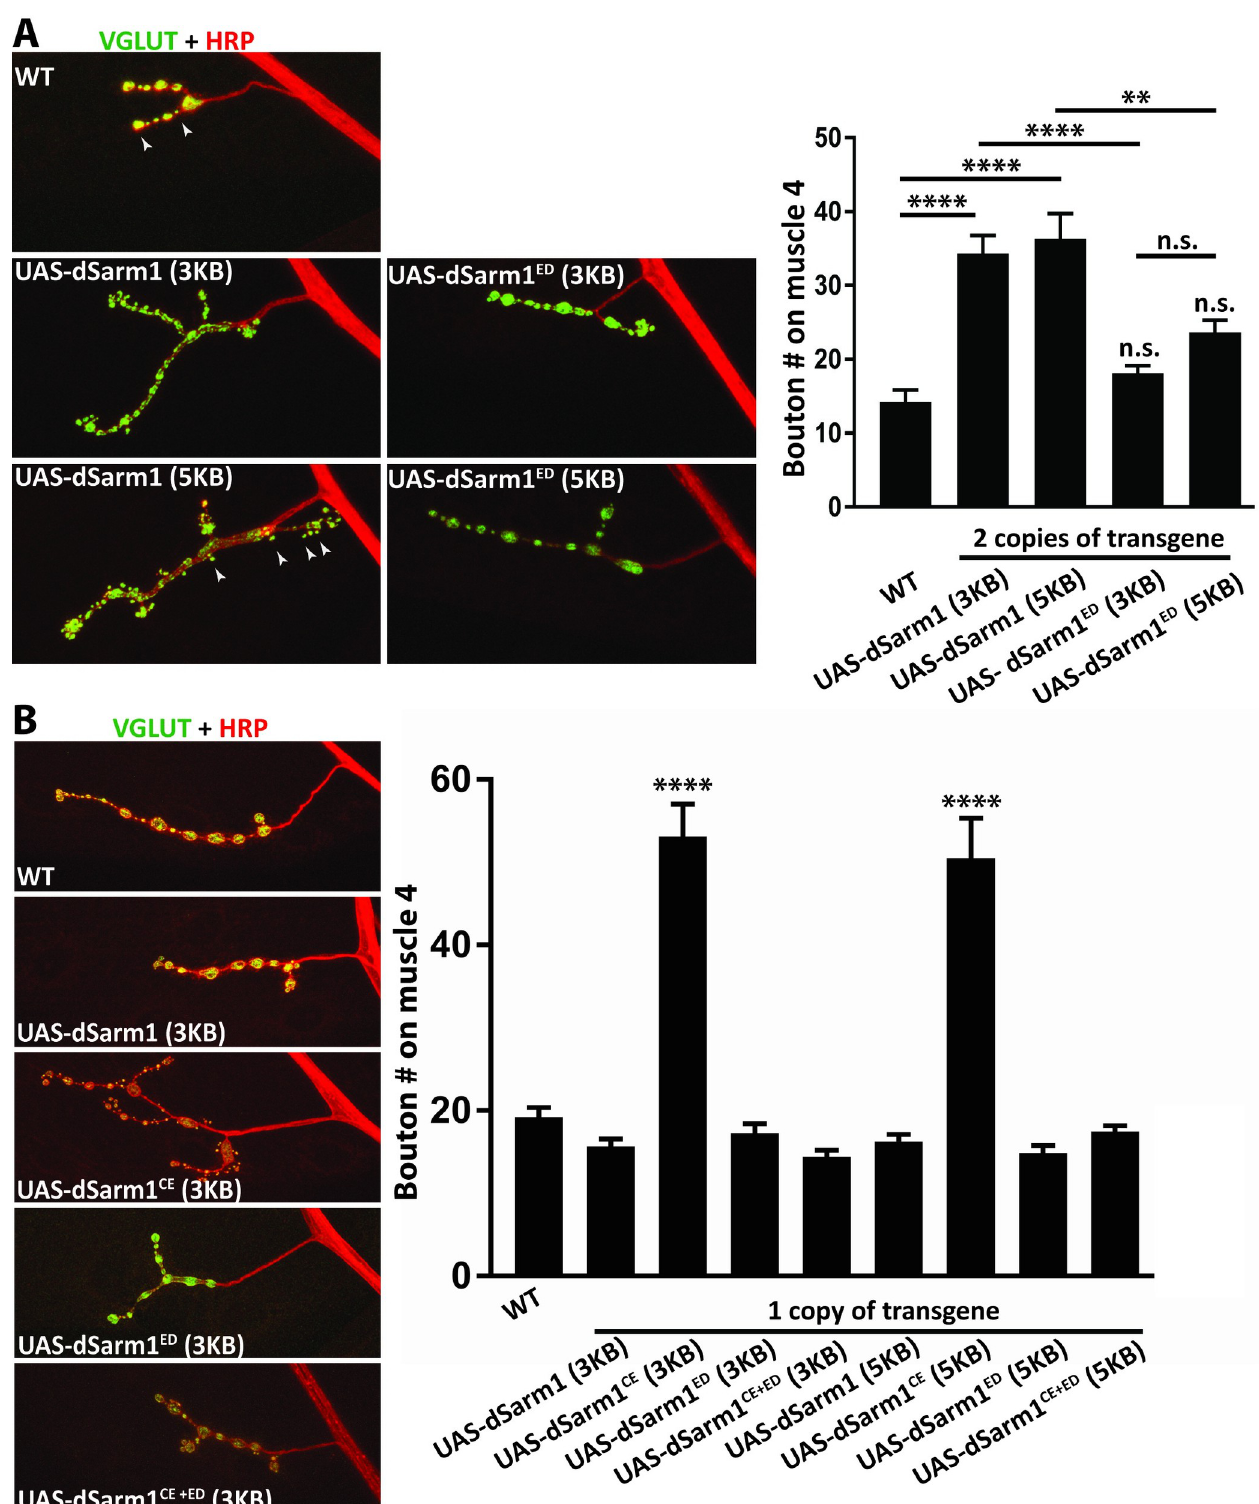
Fig 2. The NADase activity of dSarm1 is important for regulating NMJ growth. A , Overexpression ( dVGlut -Gal4) of dSarm1 leads to overgrowth of NMJ and requires the NADase activity. Representative confocal images of muscle 4 synapses from third instar larva co-stained for presynaptic dVGlut (green) and neuronal HRP (Red). Representative boutons depicted with arrowheads. Genotypes of the progeny are listed in the figure. Genotypes in Fig 2 A are